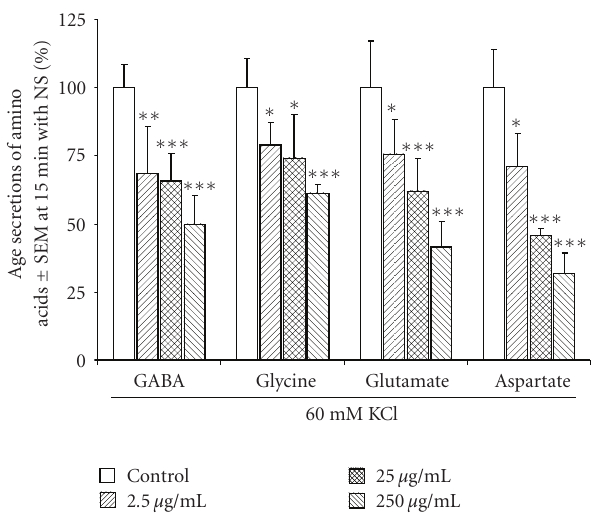
Figure 6: Secretion of amino acid neurotransmitters evoked by 60 mM KCl, measured in cortical neurons culture. The cells were previously treated with methanolic extract of Nigella sativa for 15 minutes. The values are expressed as a percentage of secretions with respect to basal value (100%). Statistical significances were calculated with respect to the corresponding control at its respective time points: ∗ P < . 05, ∗∗ P < . 01 and ∗∗∗ P < . 001 .